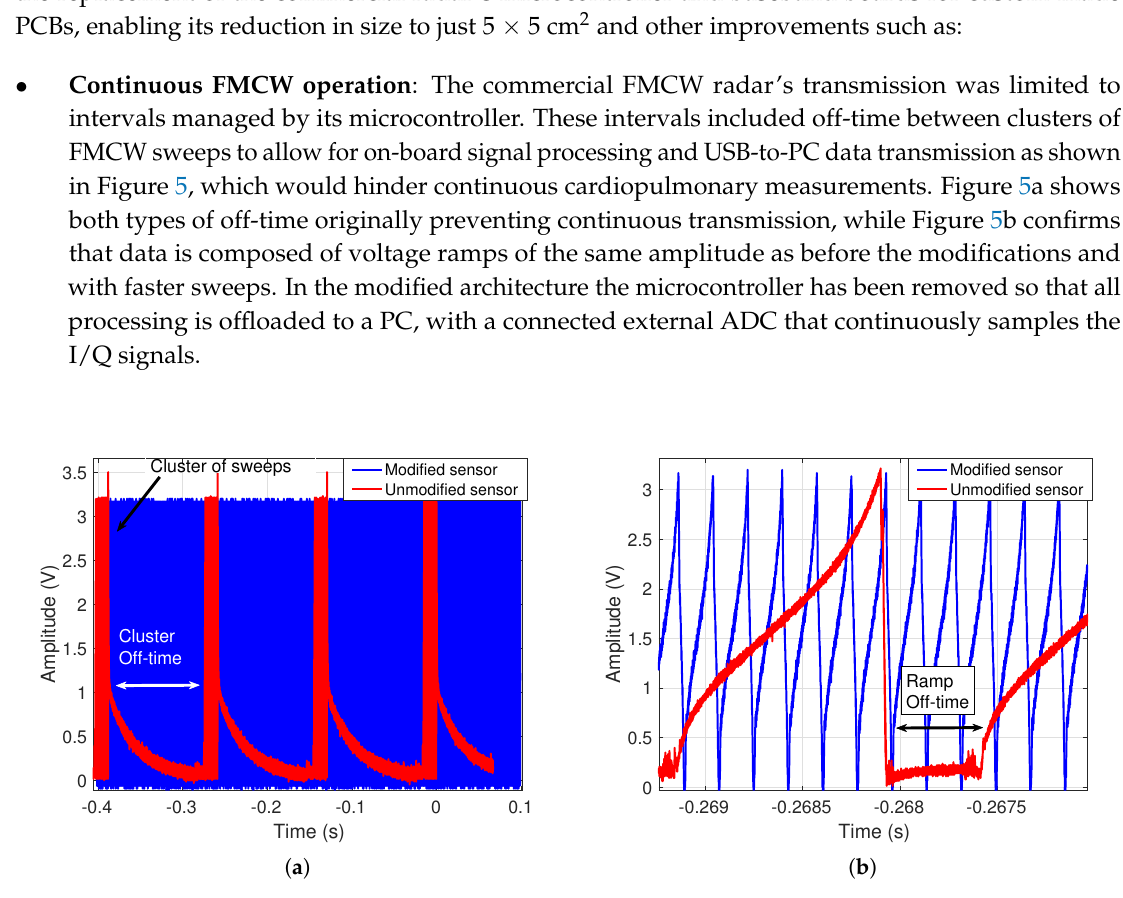
Figure 5. ( a ) Voltage ramps input into the MMIC’s VCO for FMCW operation in the modified (in blue) and commercial sensor (in red). ( b ) Zoomed-in